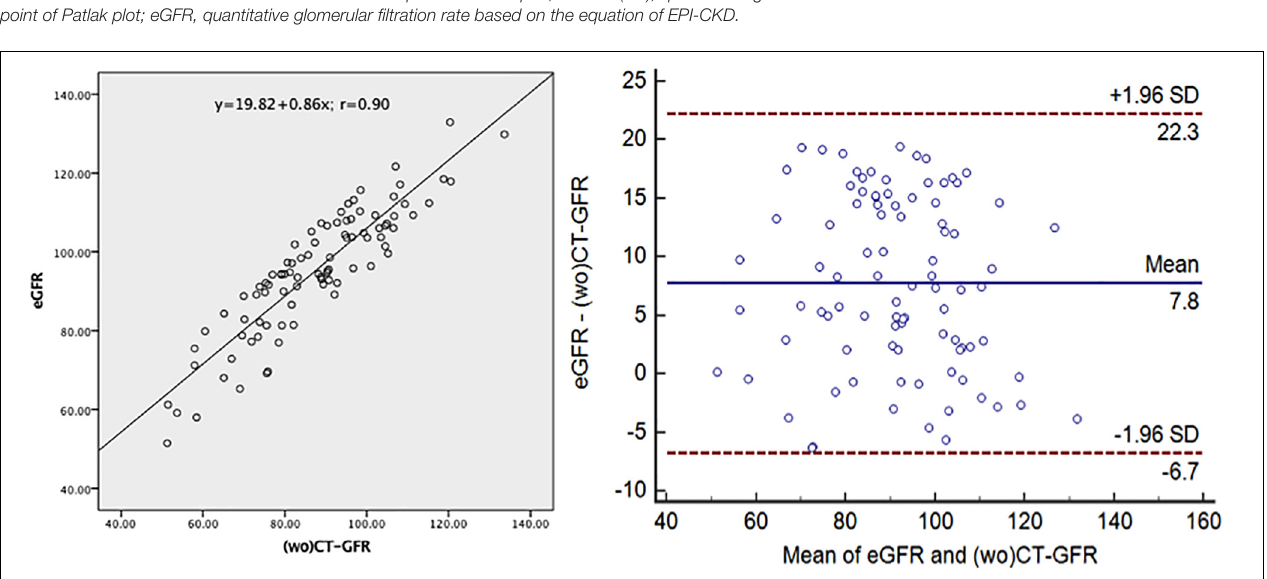
the equation of